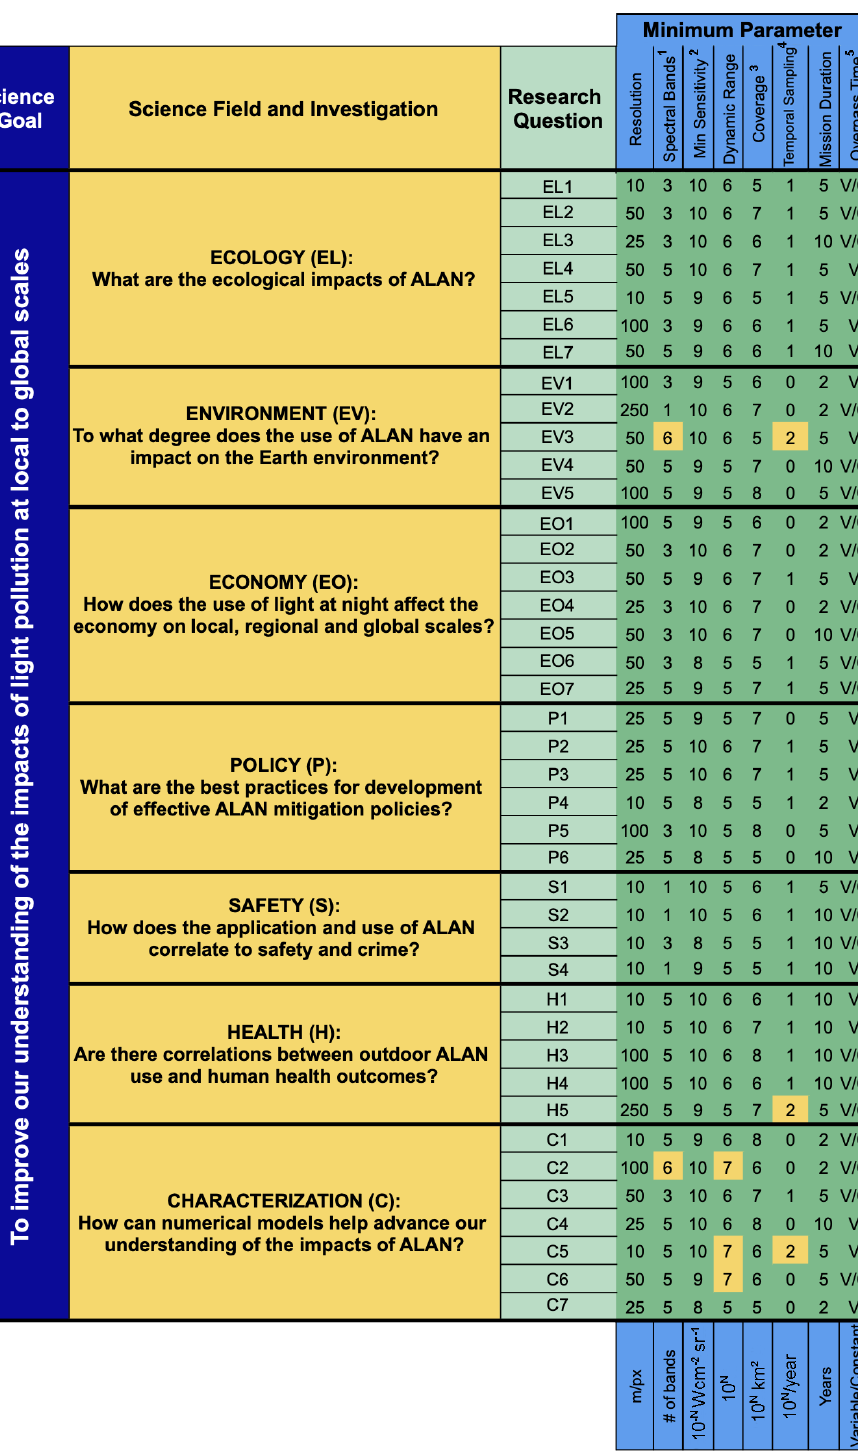
Figure 4. Science Traceability Matrix for the NITESat mission. For research questions, see ref- erence number from Section: Science Goals. Parameters in green Satisfy that question; those in yellow Improve On the question. The notes for the “Minimum Parameters” columns are as follows: (1) Spectral Bands: 1 = Broadband, 3 = RGB, 4 = RGB + Broadband, 5 = de Meester, 6 = de Meester + IR; (2) Minimum Sensitivity: 10 = Airglow, 9 = ≥ 50% Lunar Phase, 8 = Rural; (3) Coverage: 9 = Land + Sea, 8 = Global Land, 7 = National, 6 = Regional, 5 = Local; (4) Temporal Sampling: 0 = Annual, 1 = Monthly, 3 = Nightly, 4 = Multiple Nightly; and (5) Overpass Time: V = Variable, C = Constant, V/C = No